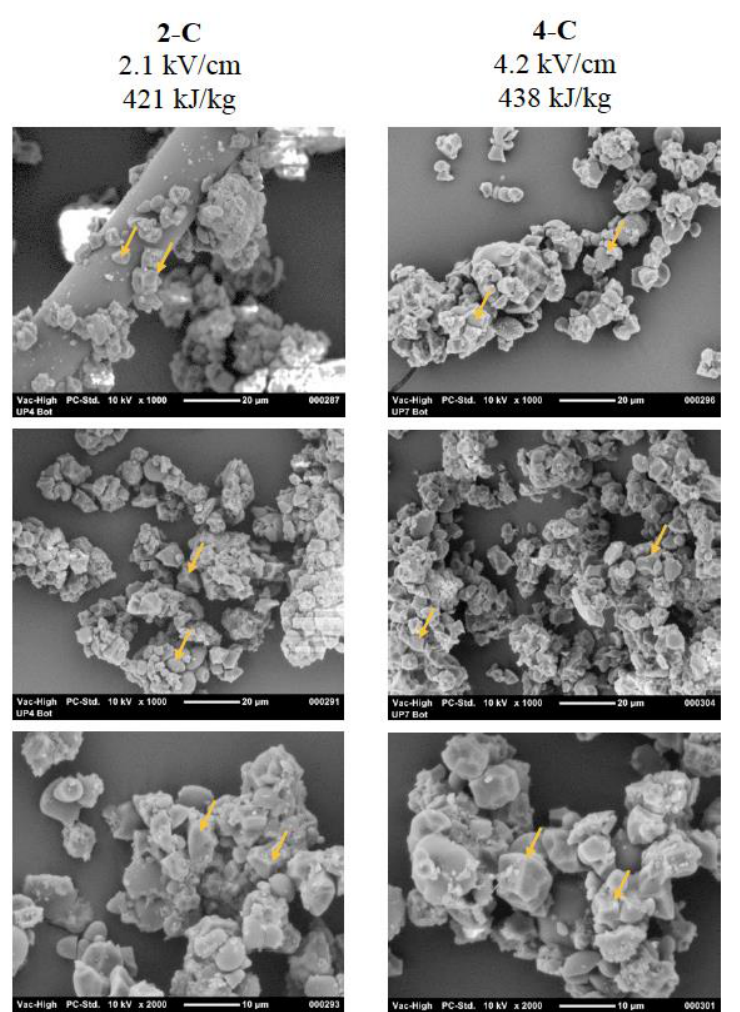
Figure 5. Scanning electron micrographs of selected Solid Segment 3 (SS3) samples from PEF-treated oat flour. SEM images are presented at 1000 × (rows 1 and 2) and 2000 × (row 3) magnifications. Yellow arrows point to the intact/undeformed granules of starch indicating that PEF treatment of oat flour at 2.1 kV/cm, 421 kJ/kg (2-C) and 4.2 kV/cm, 438 kJ/kg (4-C) did not cause significant impact on starch granules comprising SS3 samples.